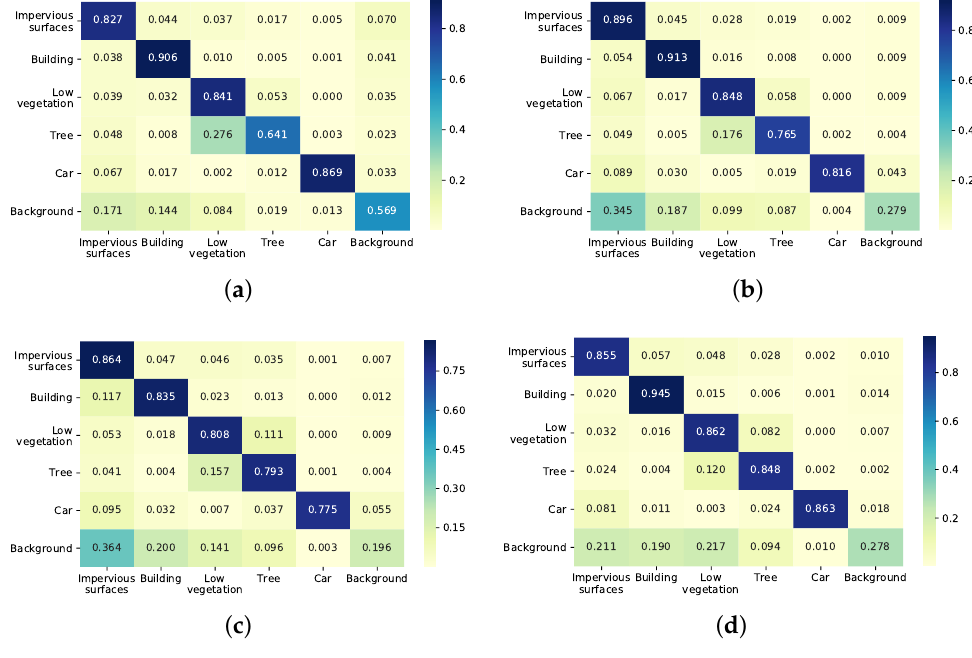
Figure 13. Confusion matrices on the Potsdam dataset. ( a ) PSPNet; ( b ) HRNet V2; ( c ) SDFCN V1; ( d )